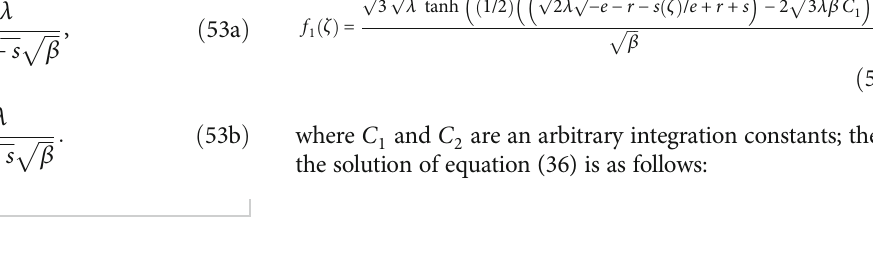
ffiffiffiffiffiffiffiffiffiffiffiffiffiffiffiffiffiffi − e − r − s